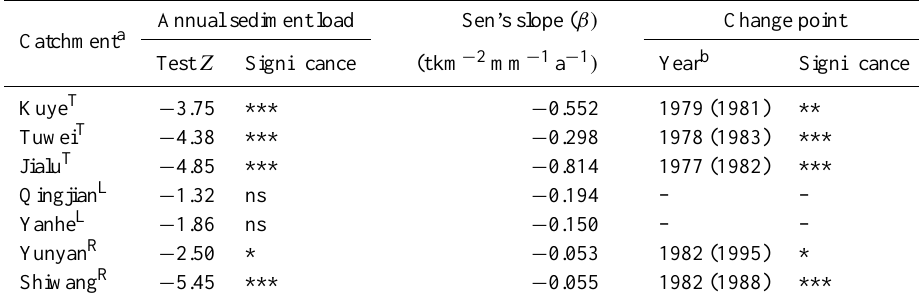
Table 5. Trends of the annual sediment load and change points by the Mann-Kendall and Pettitt